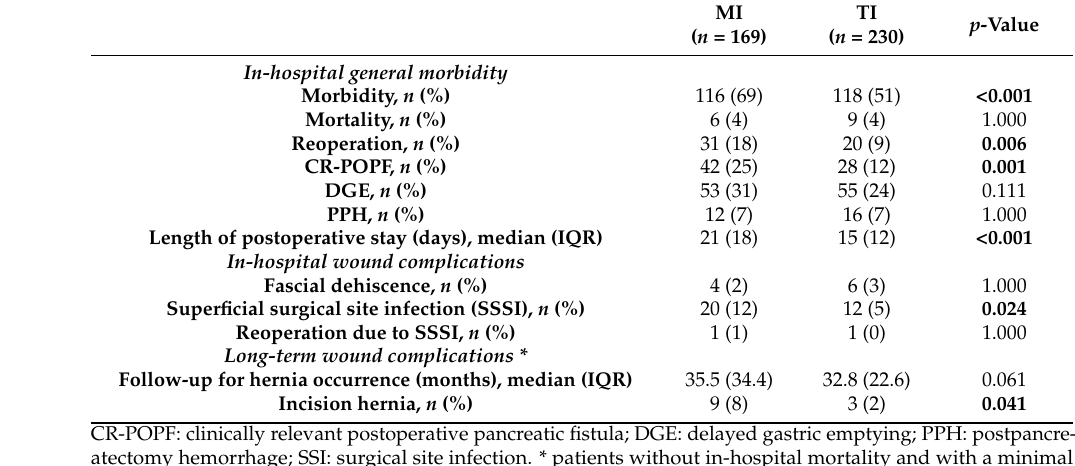
Table 3. Outcome parameters of patients undergoing pancreatoduodenectomy ( n = 399 and 249, respectively) stratified by incision type (MI (midline incision) vs. TI (transverse incision)).